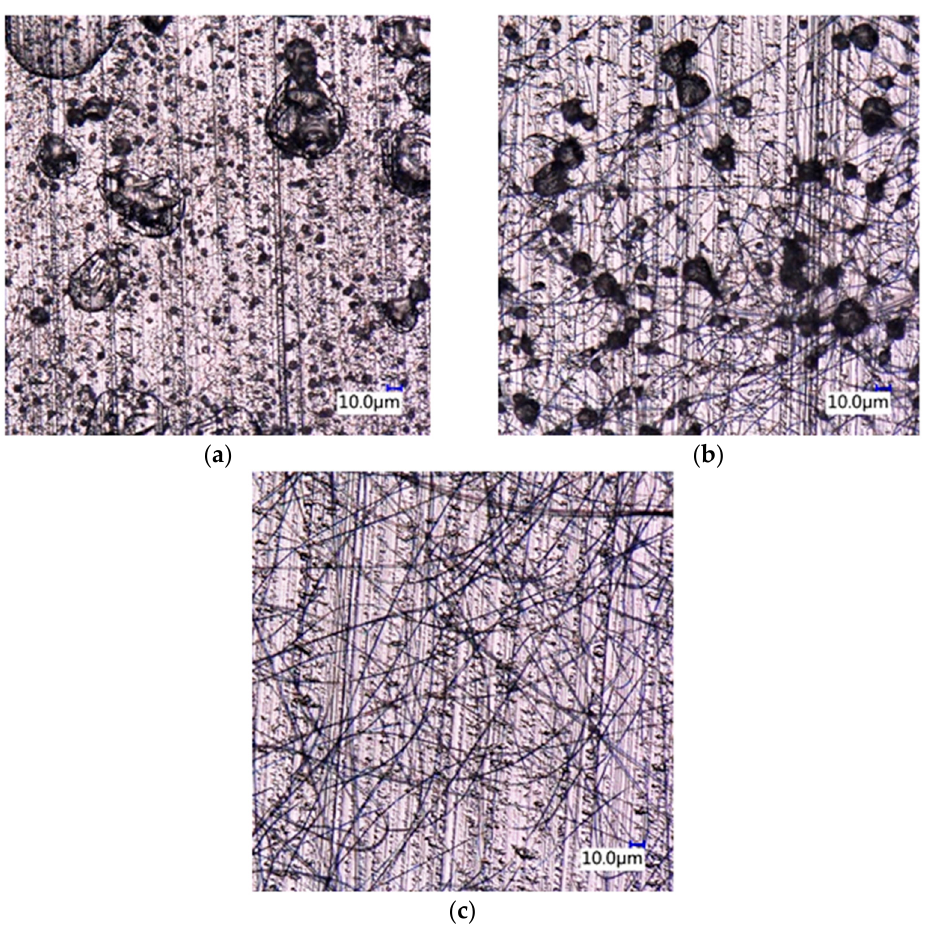
Figure 1. Effect of the concentration of PVP spinning solutions on the quality of the product; ( a ) 25, ( b ) 30, ( c ) 40 wt%.